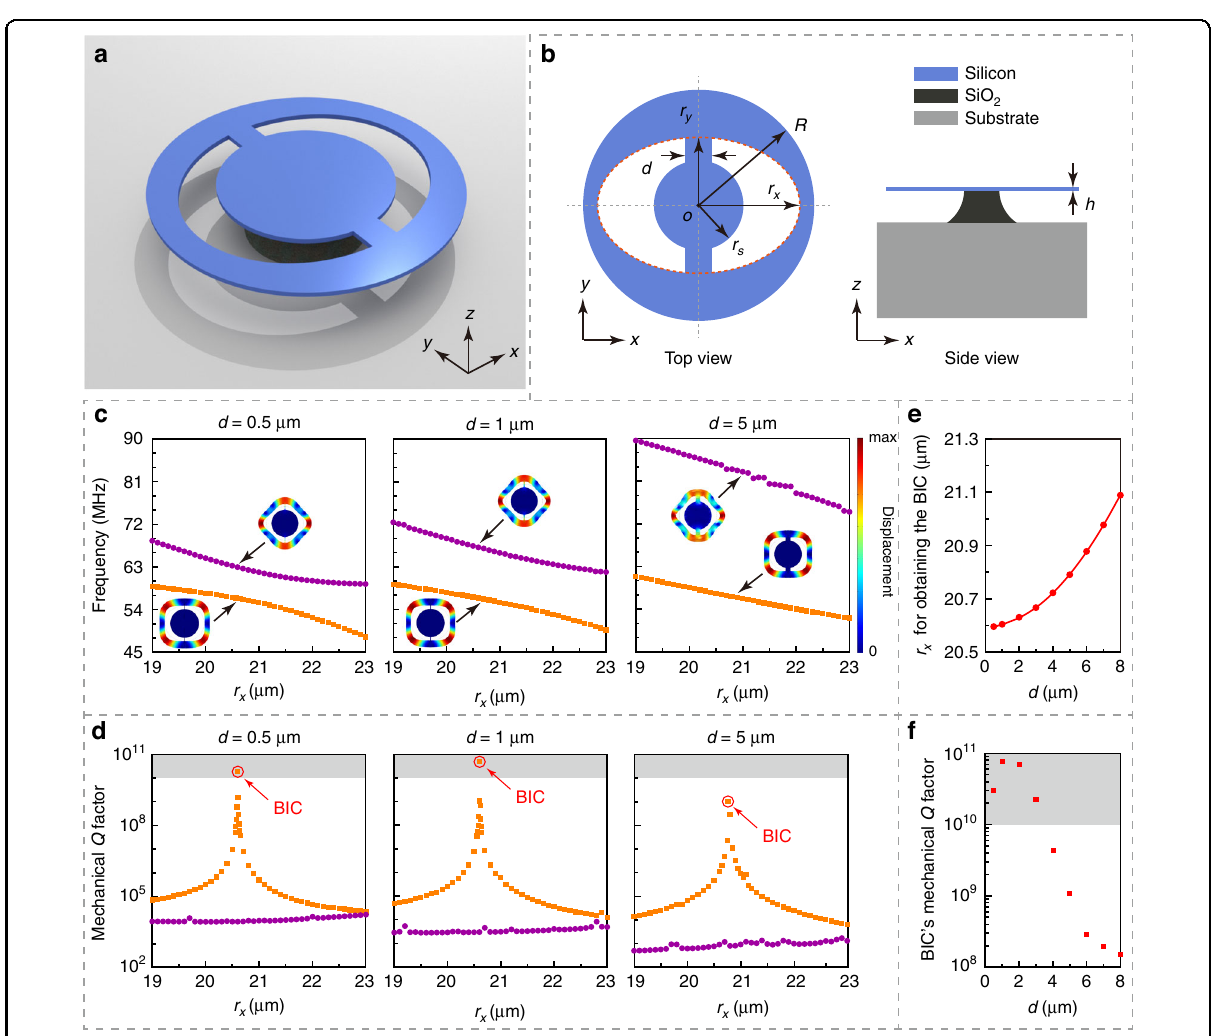
Fig. 2 Design and numerical simulation of mechanical BIC in a micromechanical resonator. a Illustration of the wheel-shaped micromechanical resonator that supports mechanical BIC. b Top and side views of the micromechanical resonator, with dimension labels. c Simulated frequencies of modes A' and B' of the micromechanical resonator as a function of r x for d = 0.5, 1, and 5 μ m. The insets show the corresponding modal displacement pro fi les. d Simulated mechanical Q factors of modes A' and B' as a function of r x for d = 0.5, 1, and 5 μ m. The BIC point where the highest mechanical Q factor is achieved is marked in each plot. e The value of r x for obtaining the BIC as a function of d . f Simulated mechanical Q factor of the BIC as a function of d . In ( c – f ), the fi xed geometric parameters of the micromechanical resonator are r y = 18.7 μ m, R = 26.1 μ m, r s = 14.7 μ m, and h = 220 nm. In ( d) and ( f ), the gray areas indicate the regimes reaching the limit of numerical simulation, where